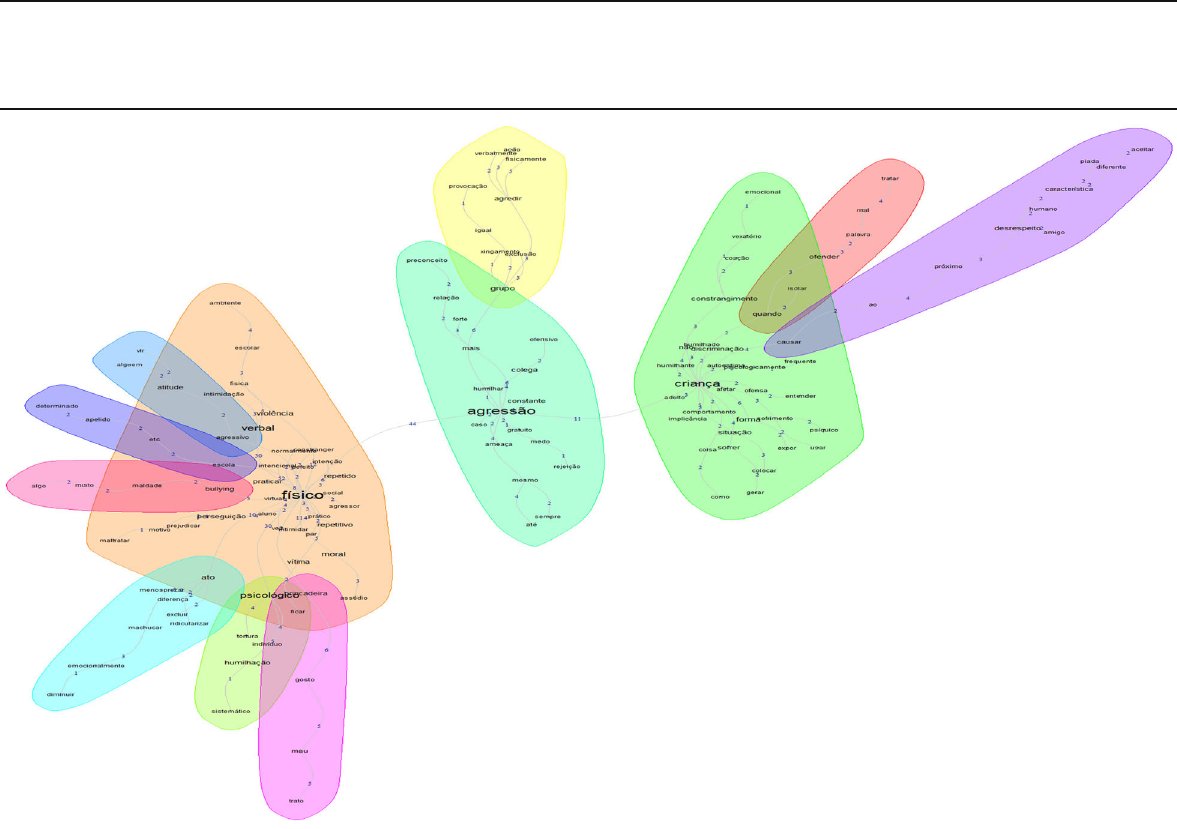
Fig. 2 Similarity analysis of the